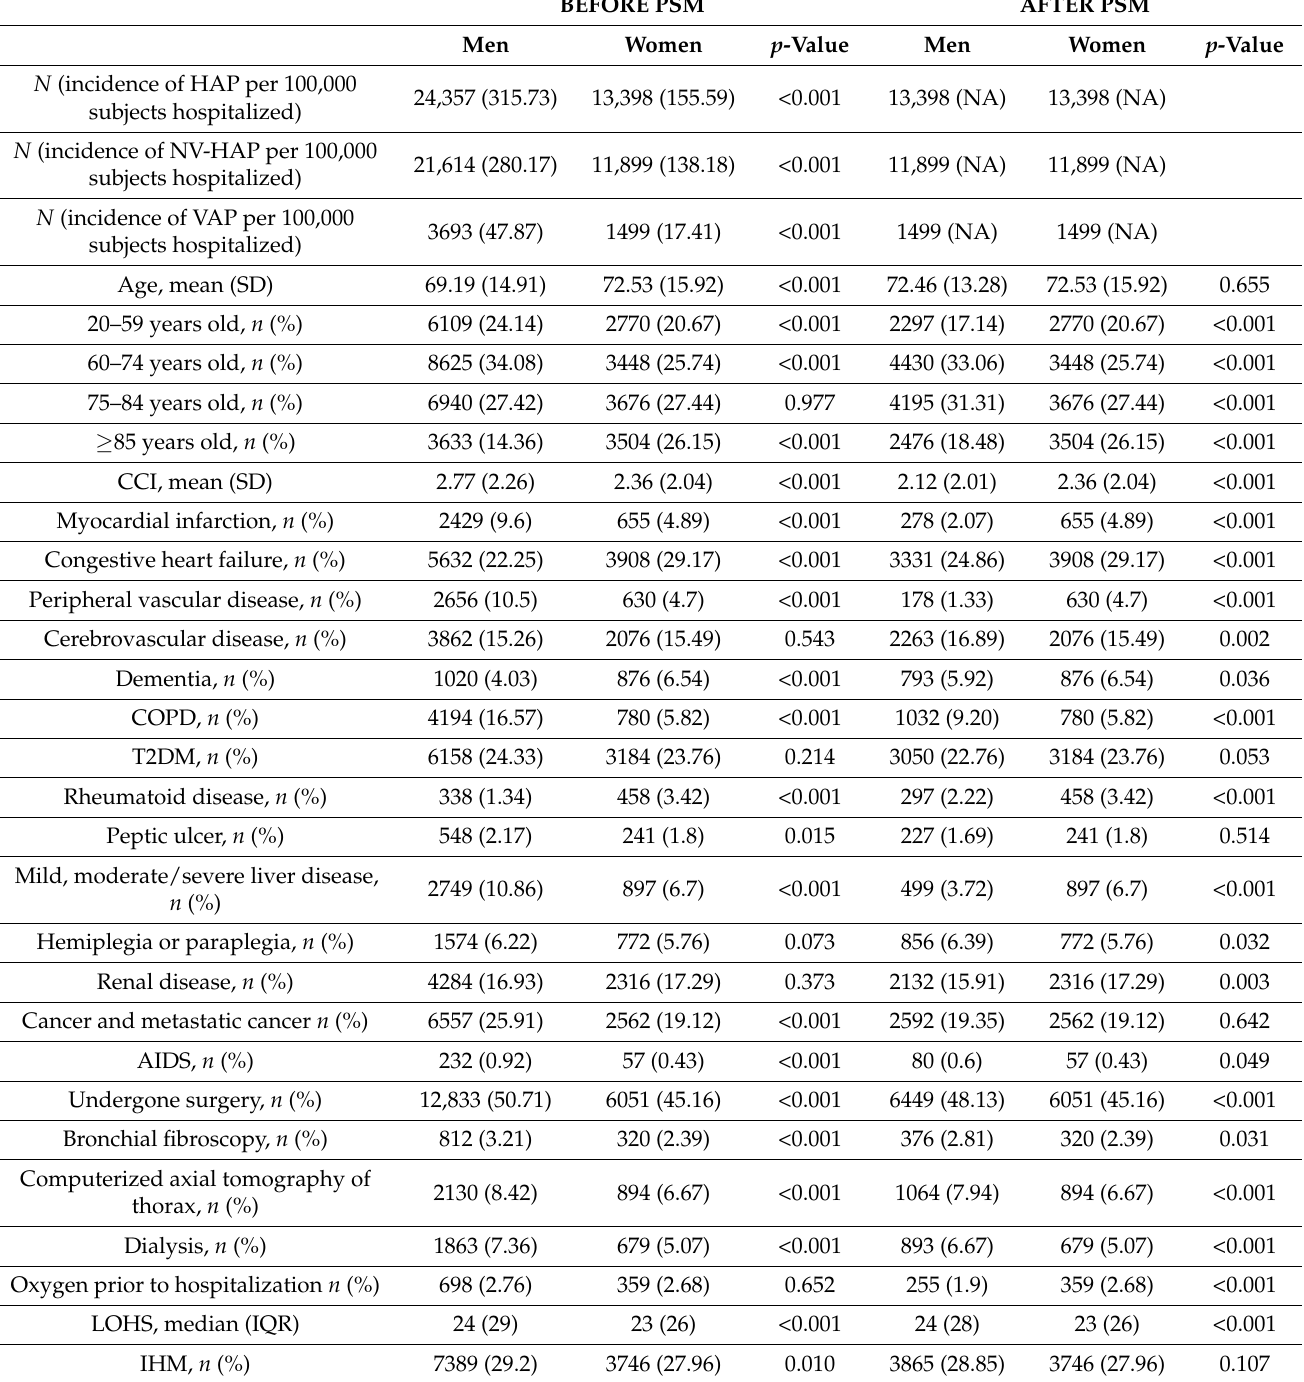
Table 4. Incidence distribution of study covariates and hospital outcomes for women and men who developed hospital- acquired pneumonia (HAP) in Spain (2016–2019), before and after propensity score matching (PSM). BEFORE PSM AFTER